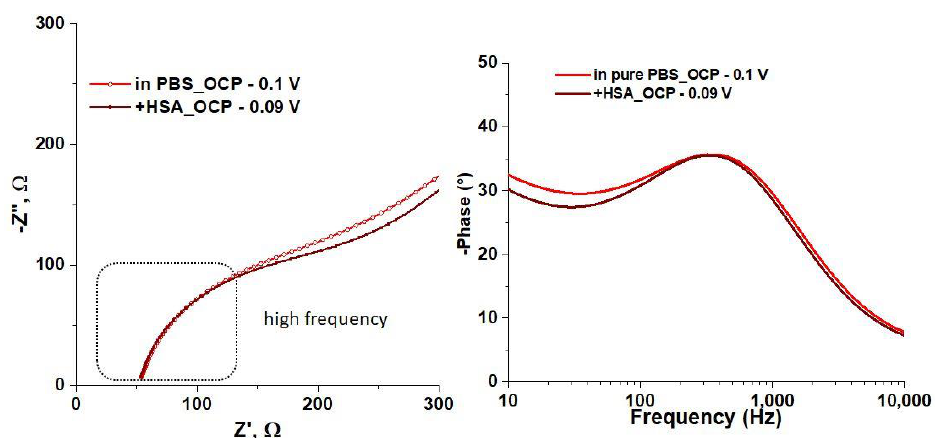
Figure 5. EIS of PNaSS@PEDOT microspheres film in the presence of human serum albumin (HSA) measured at different conditions: before and after applying HSA, ( a ) the Nyquist plots, and ( b ) the Bode plots.